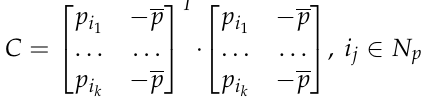
Figure 5. Overview of the Doric columns of Taranto ( a ); remains of the third column used for the fourth test ( b ).